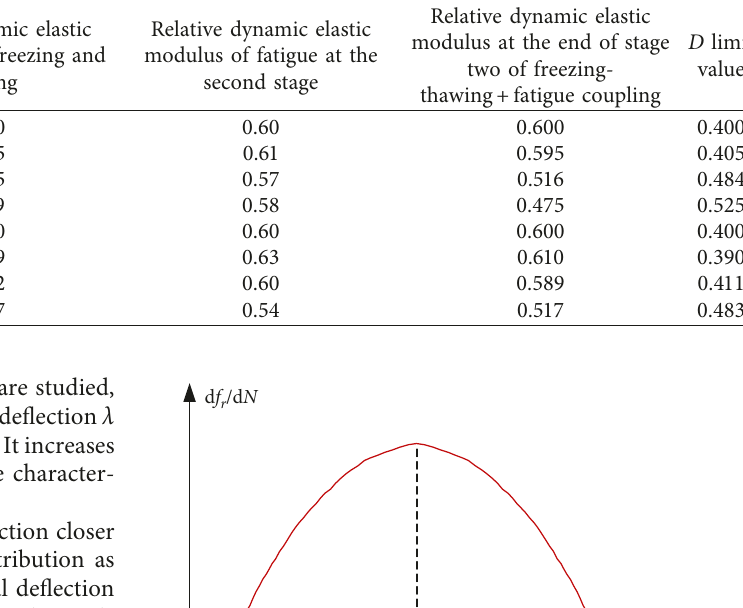
Table 7: Damage criterion of the relative elastic modulus of the test beam after freezing and fatigue.